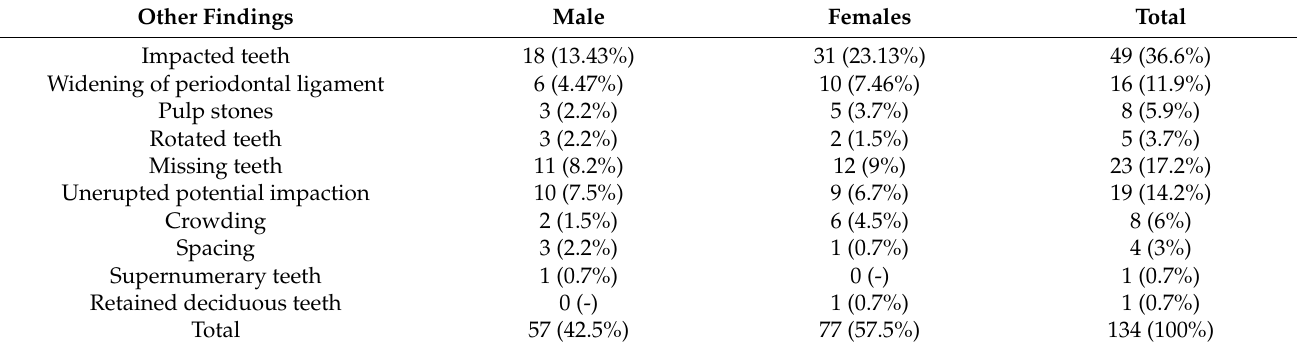
Figure 3. Incidental pathologic findings according to the jaw location. Other abnormalities detected, in addition to the IPFs, were found in 76 (76%) of panoramic radiographs. These findings were seen in 33 panoramic radiographs with IPFs and 43 that did not have IPFs. Table 3 shows that a total of 134 other findings were detected from the 76 panoramic radiographs, n = 57 (42.5%) findings were in males and n = 77 (57.5%) in females. Impacted teeth were the most common type of other findings (n = 49) and more predominant in females, followed by missing teeth (n = 23), unerupted potential impactions (n = 19), and widening of the periodontal ligament (n = 16). The other findings ranged between one and eight. Table 3. Other abnormalities in males and females.